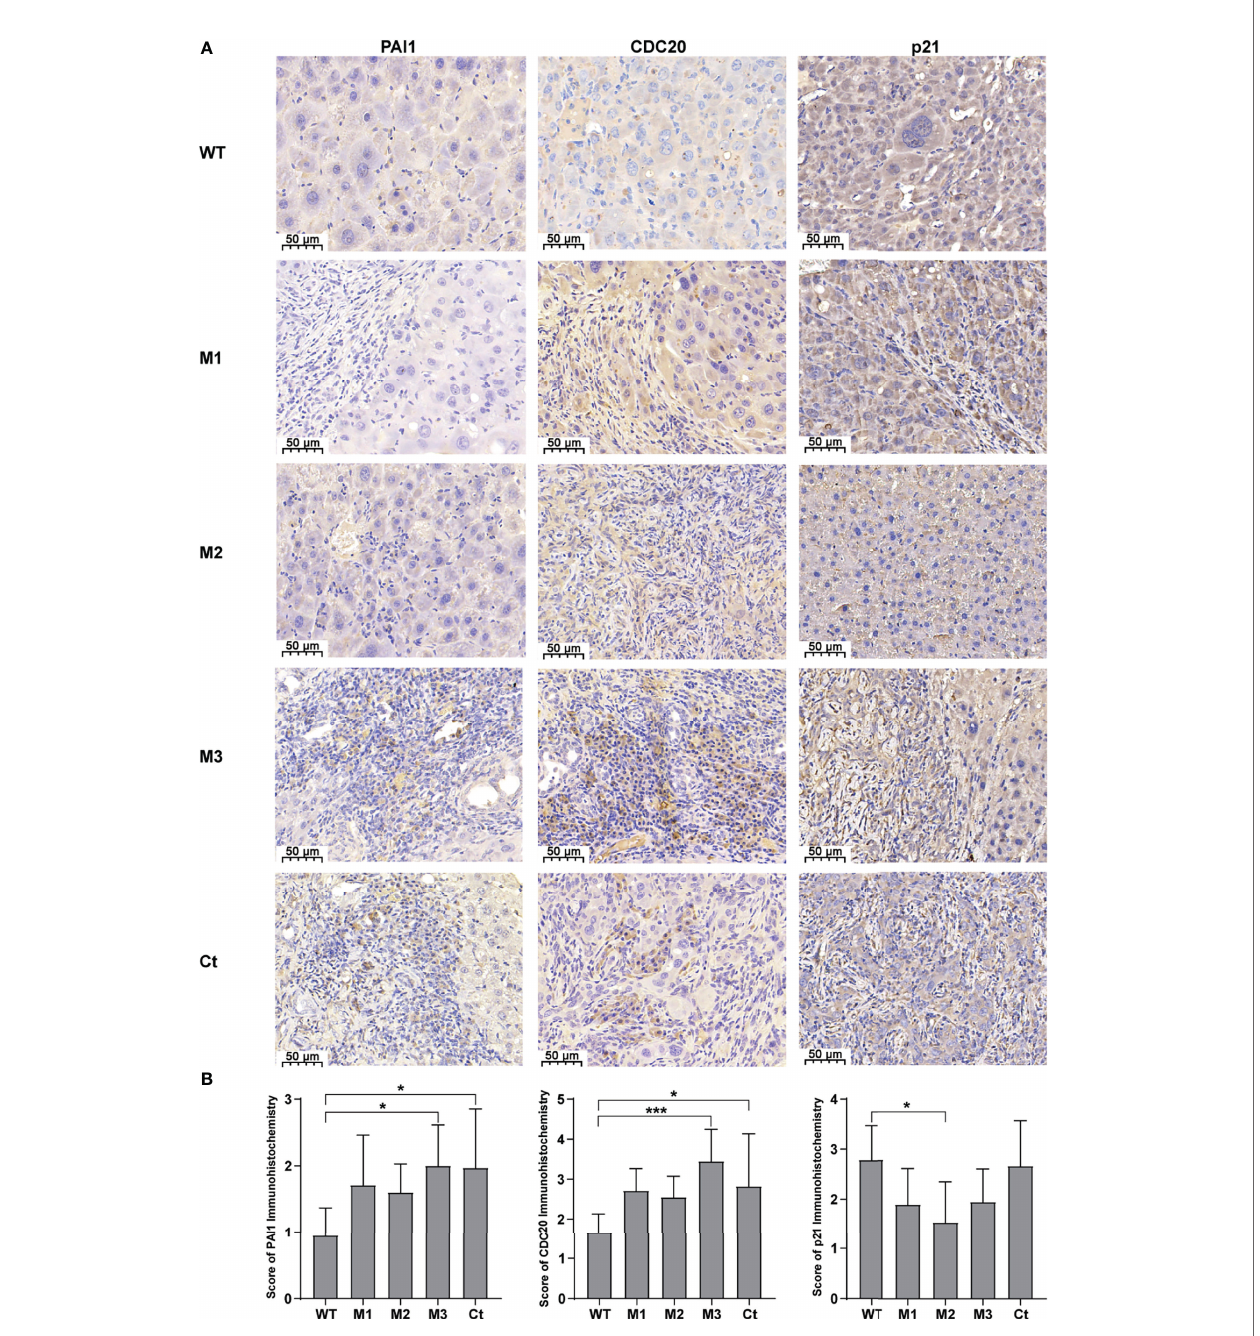
FIGURE 7 | The expression levels of PAI1, CDC20, and p21 in the mouse tumor tissues of the SB mouse models injected with WT-HBx or each of the four HBx mutants. (A) Representative IHC images of PAI1 staining, CDC20 staining, and p21 staining. (B) Histograms of the IHC scores for the protein expression of PAI1, CDC20, and p21. * P < 0.05; *** P <